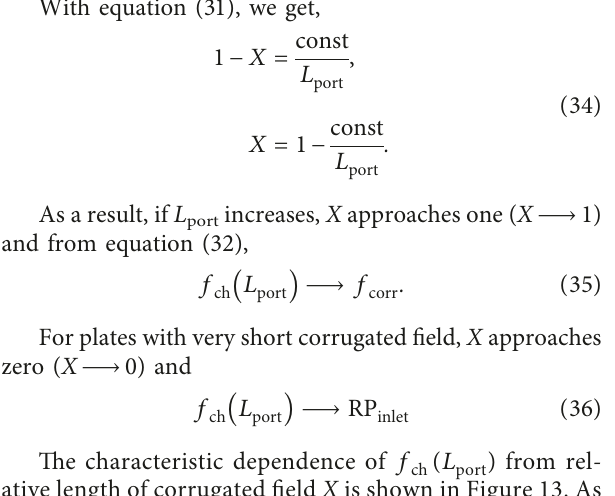
Figure 12: Fanning friction factor f plates